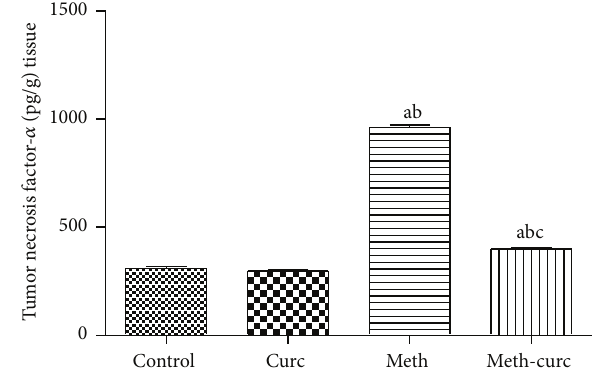
Figure 4: Effect of curcumin (Curc) on renal tumor necrosis factor- 𝛼 level of methotrexate- (Meth-) induced nephrotoxicity in rats. Data are mean ± SEM of 6–8 rats. a , b , c Significantly different from control, Curc, and Meth groups, respectively, at 𝑃 < 0.05